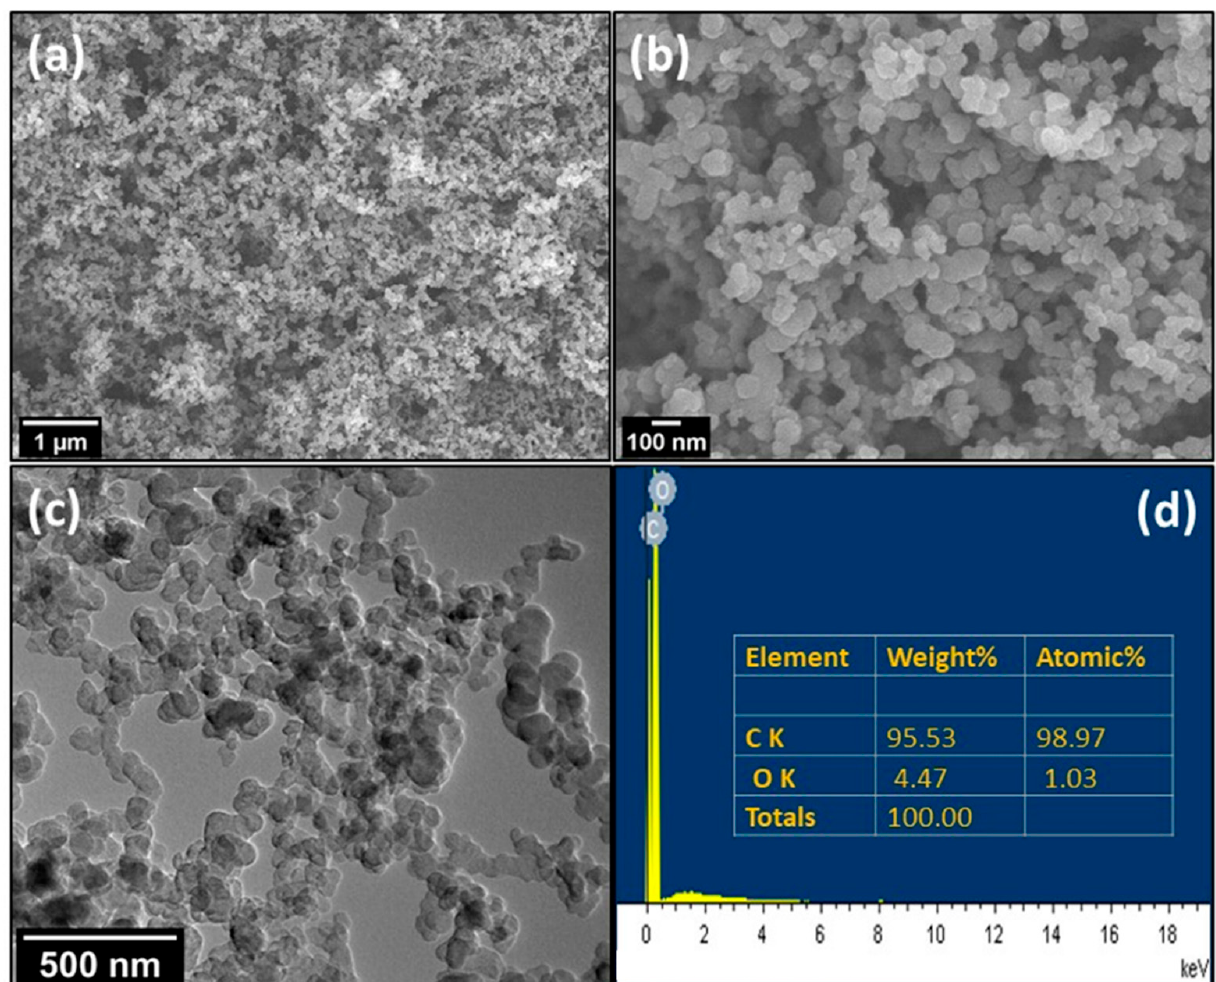
Figure 2. FESEM images of activated carbon at ( a ) low magnification and ( b ) high magnification. ( c ) TEM image of activated carbon and ( d ) EDX spectrum of activate carbon.